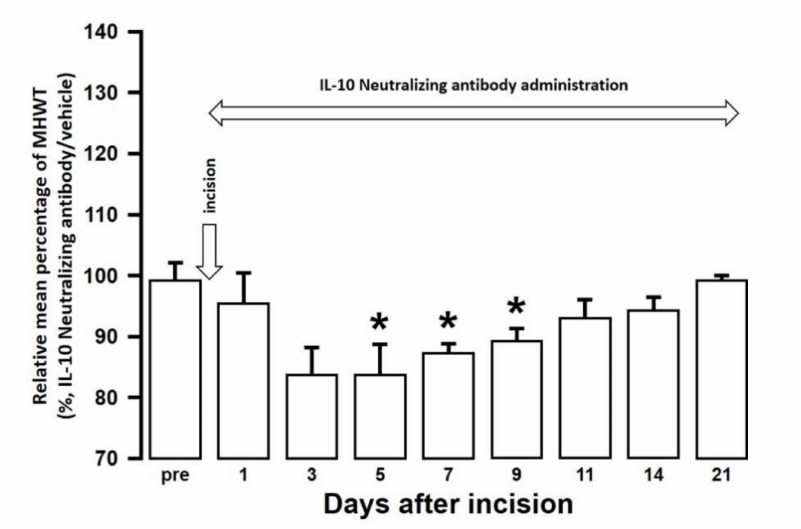
Figure 8. Changes in MHWT in SAMR1 mice treated with either an IL-10 neutralizing antibody or vehicle following palatal mucosal incision. The relative mean percentage MHWT was calculated over 21 days using the following formula (100 × MHWT in SAMR1 mice treated with an IL-10 neutralizing antibody / MHWT in SAMR1 mice treated with vehicle). Data represent mean ± SD ( n = 5 for SAMR1 incision mice treated with an IL-10 neutralizing antibody, and SAMR1 incision mice treated with vehicle. * p < 0.05, compared to pre-value; one-way repeated measures ANOVA followed by Tukey’s multiple comparison test).